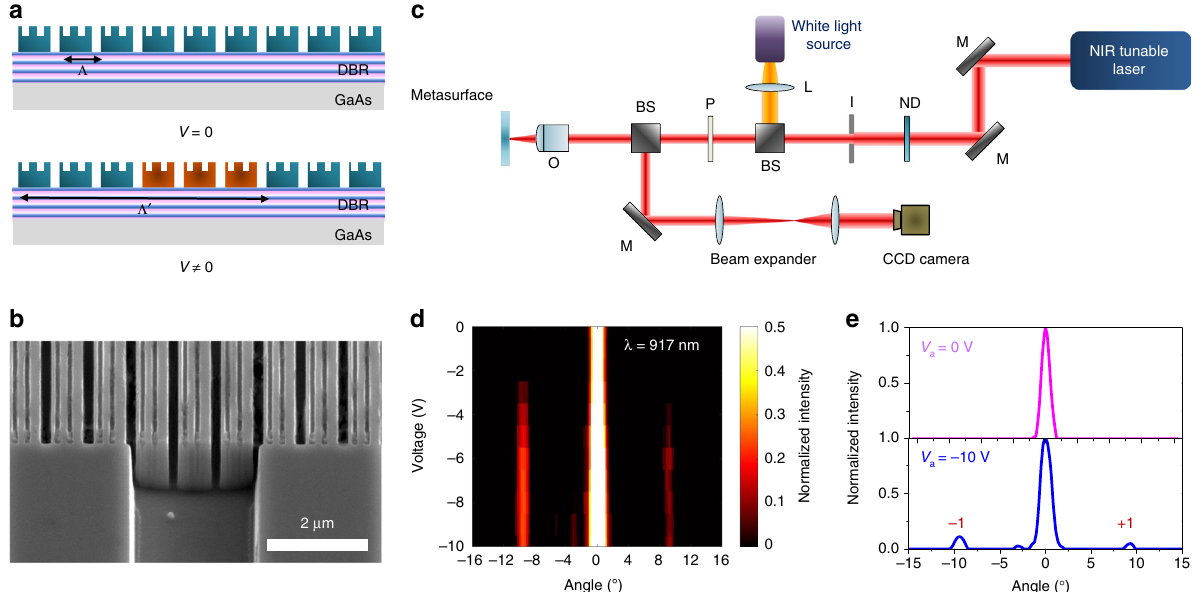
Fig. 4 Demonstration of switchable diffraction grating. a Schematic of the dynamic diffraction grating, which can be realized by changing the grating periodicity via an appropriate bias application. b SEM image of the fabricated sample, which we used for the demonstration of the dynamic beam switching. c Optical setup for far- fi eld radiation pattern measurements. M: mirror, ND: neutral density fi lter, I: iris, BS: beam splitter, O: objective with 0.28 numerical aperture, L: lens. d Experimentally measured intensity of the scattered light in the far- fi eld as a function of diffraction angle and applied voltage. The fi rst- order diffracted beam appears when the applied voltage is lower than − 3 V. The plotted diffracted light intensity is normalized to the light intensity at 0°. The light intensity is plotted for a wavelength of 917 nm. e Intensity of the scattered light as a function of the diffraction angle at an applied bias of 0 V (top panel) and at an applied bias of − 10 V (bottom panel). The ±1 diffraction order clearly appears when the applied voltage is decreased to − 10